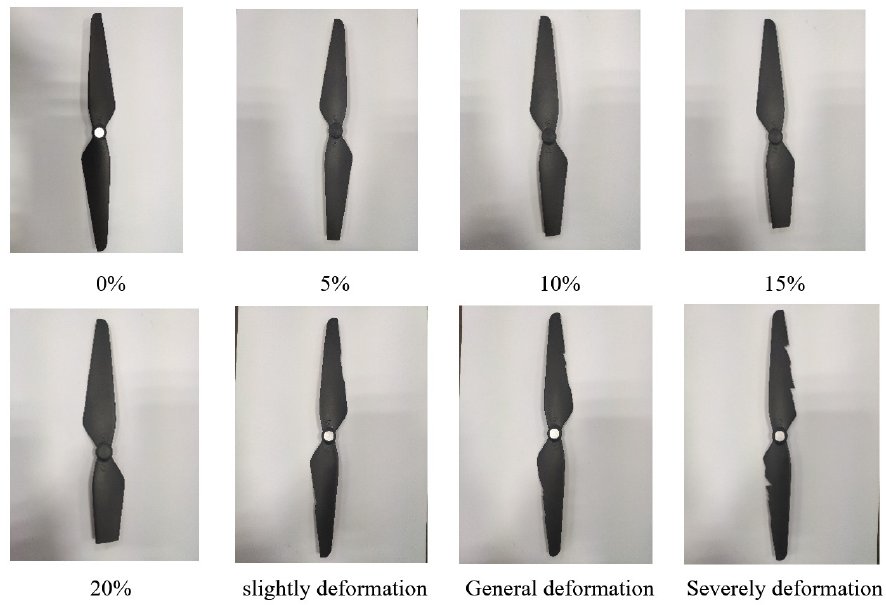
Figure 7. Eight different types of blade damage.